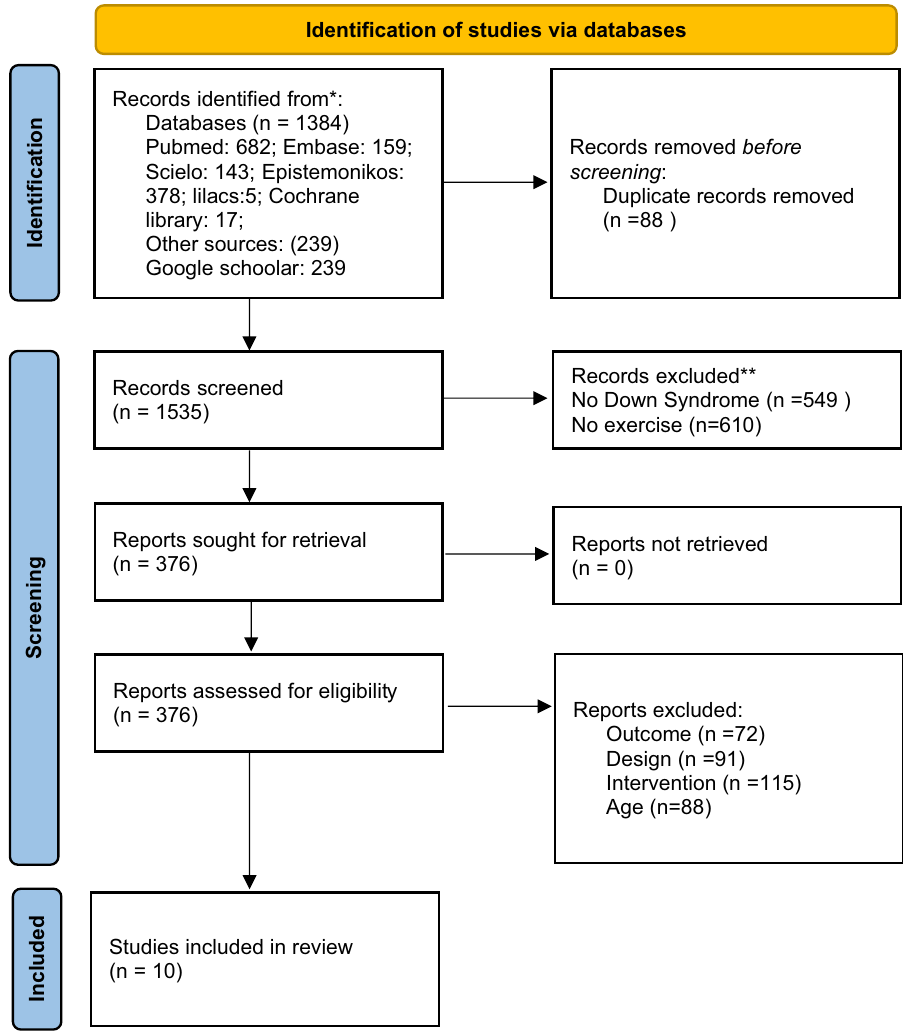
Figure 1. Flow chart of studies included. Adapted from: Page MJ, McKenzie JE, Bossuyt PM, Boutron I, Hoffmann TC, Mulrow CD, et al. The PRISMA 2020